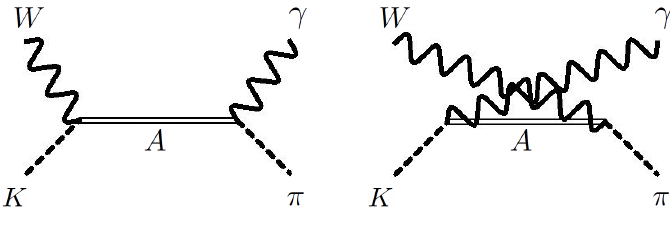
Figure 4 . The resonance contribution to T Kπ